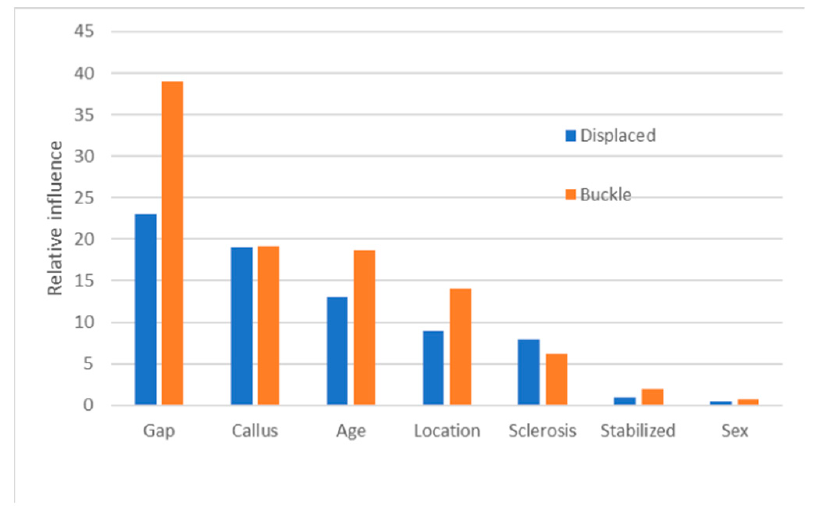
Figure 4. Relative contribution of variables to variance in displaced (blue) and buckle (orange) frac- tures.